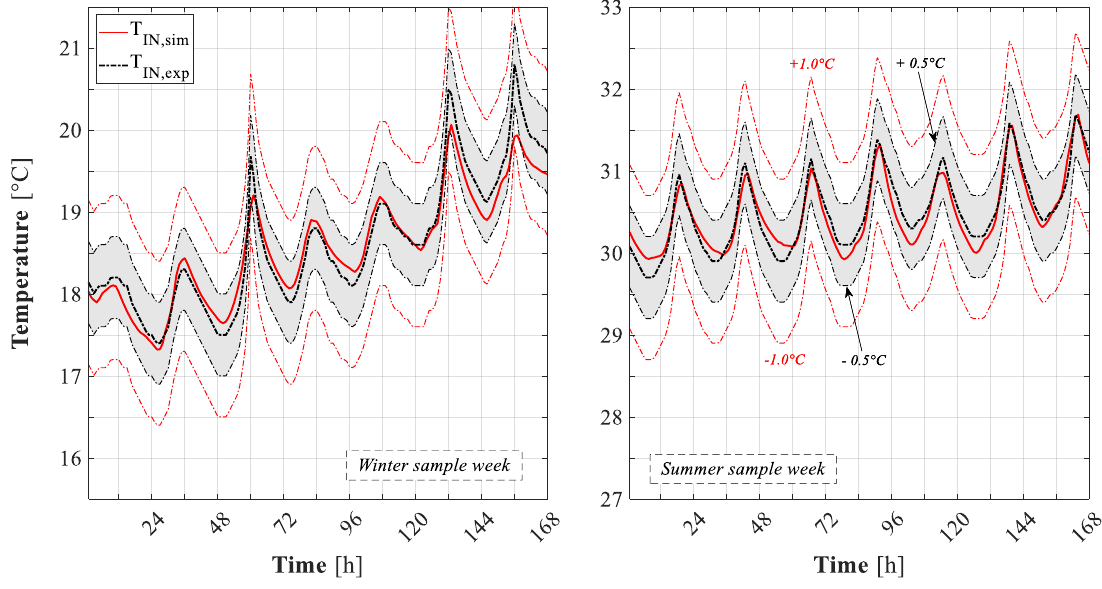
Figure 13. Indoor air temperature: simulated vs. experimental results (two sample weeks).